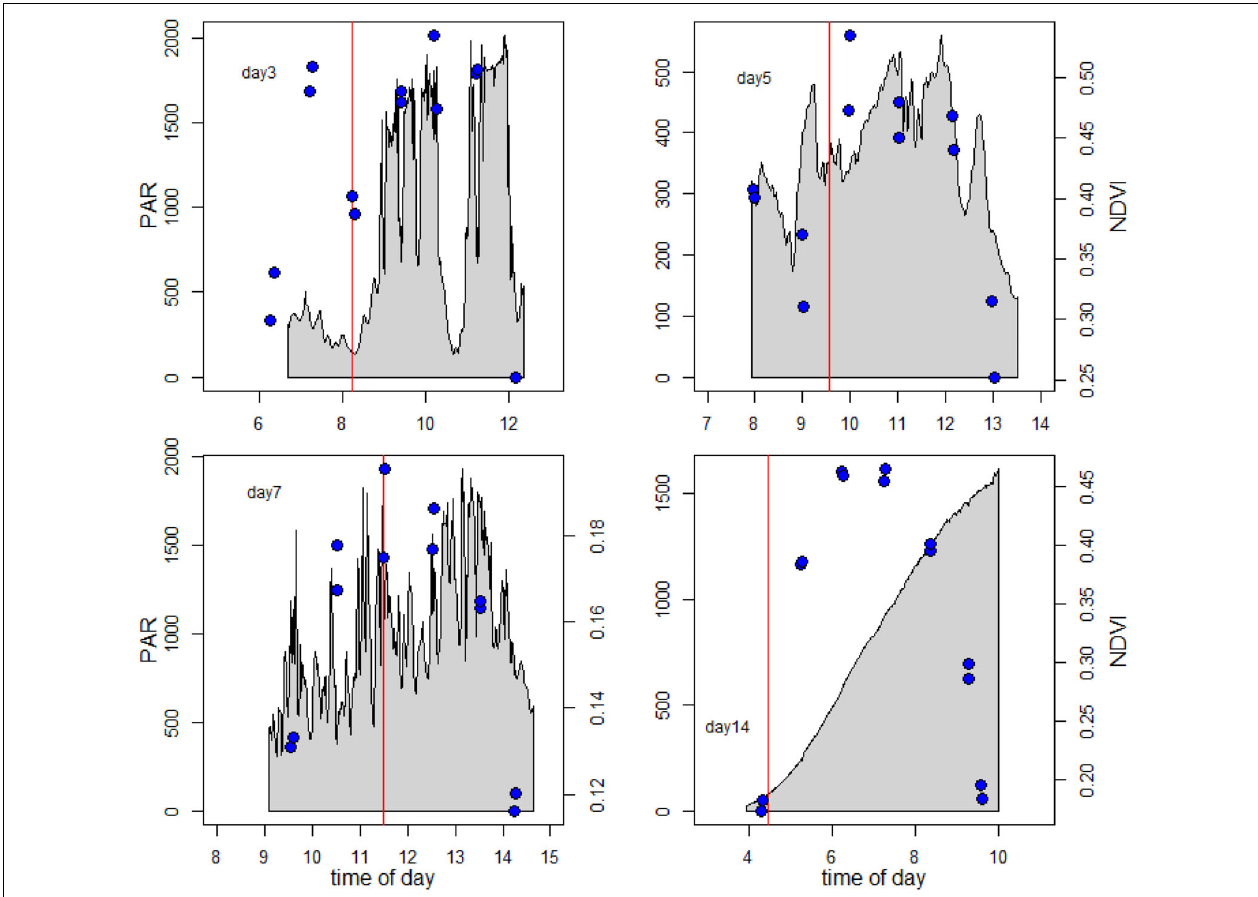
FIGURE 6 | Vertical migration patterns. The blue symbols show the measured NDVI data. The gray area shows the surface solar irradiance during the measuring period. The vertical red line gives the time of low tide.